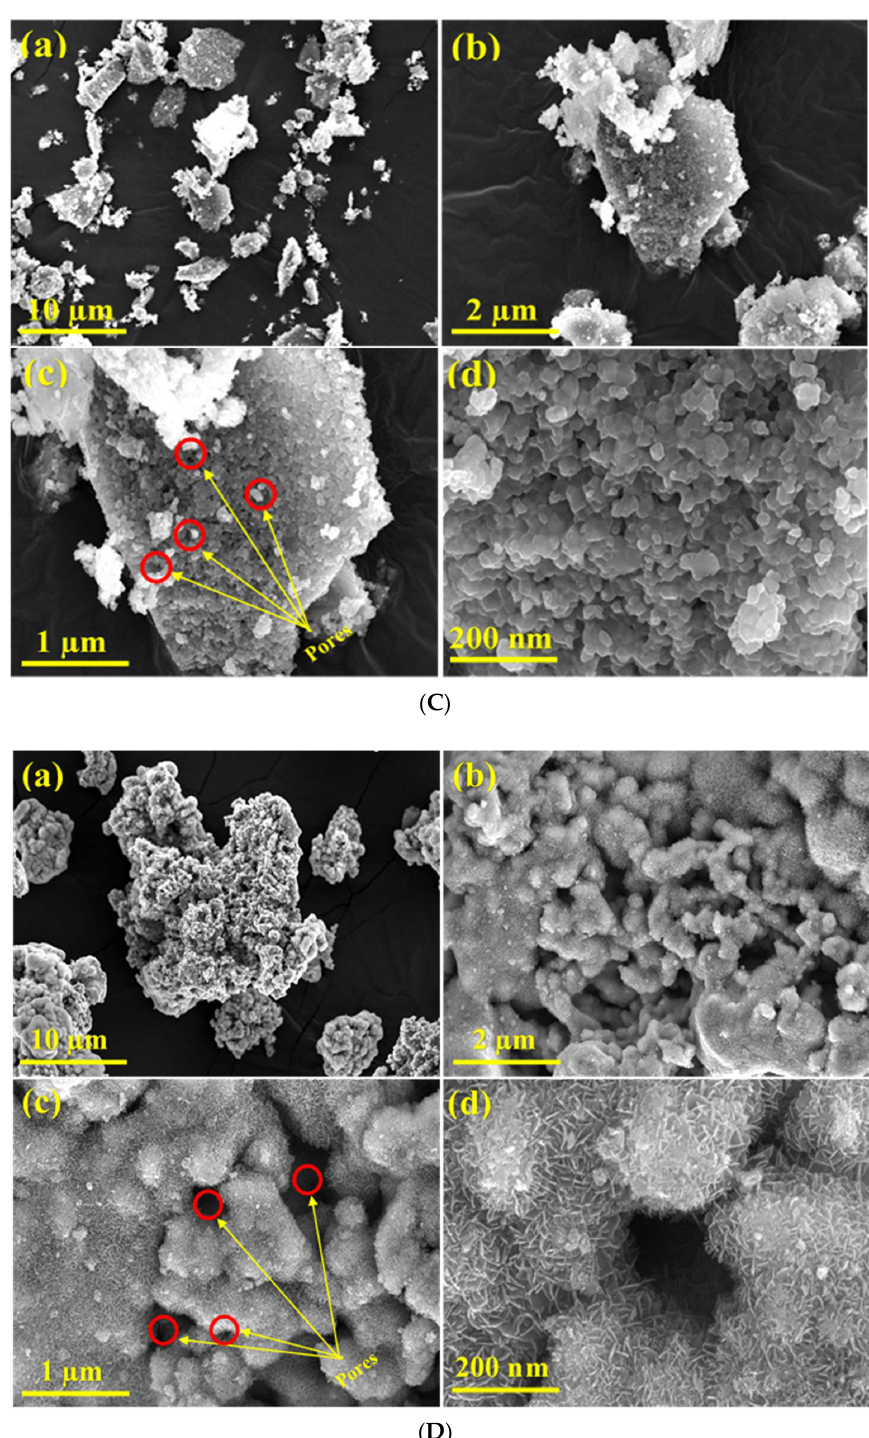
Figure 4. FESEM images of the fresh samples: ( A ) Ni, ( B ) Ni-Co, ( C ) Ni-Fe, and ( D ) Ni-Cu.